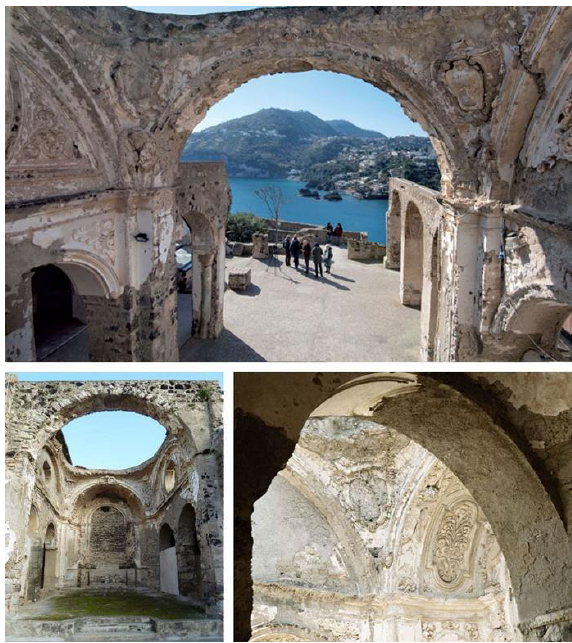
Figure 1. Assunta’s Cathedral ruins on Ischia island.